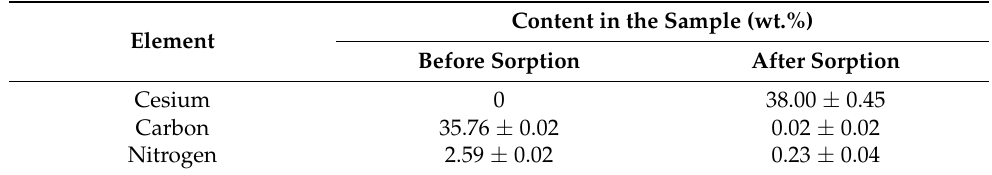
Table 4. Cesium, carbon, and nitrogen contents (in percent by mass) of the hybrid hexadecylamine- vanadium oxide, VO x -C16, material before and after sorption from a 4:1 ethanol–water mixture.